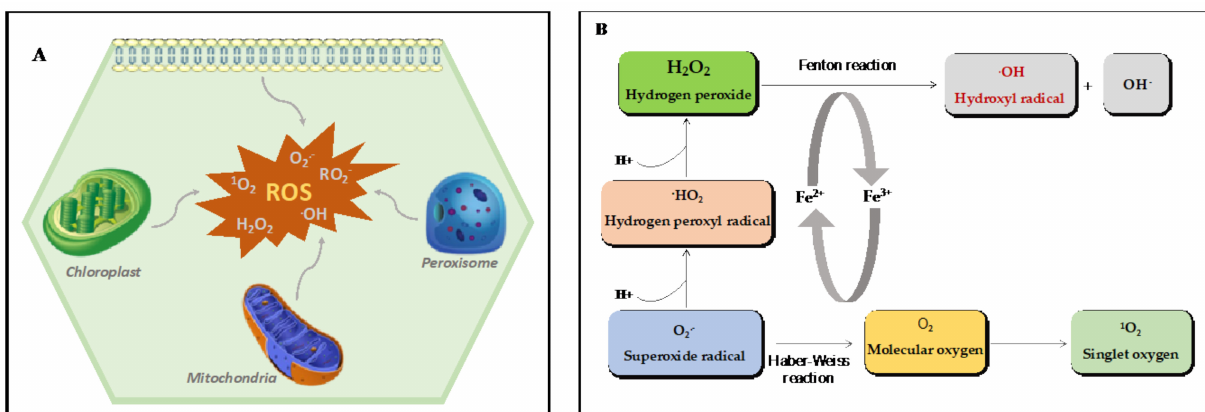
Figure 1. Environmental stress and ROS production in plants. ( A ) ROS are produced in the chloroplasts, mitochondria, peroxisomes, plasma membrane, cell walls, and apoplasts under normal growth conditions. However, environmental stresses exacerbate their production and may lead to oxidative stress. ( B ) The Fenton reaction and Haber–Weiss reaction. ROS are partially reduced or activated forms of molecular oxygen. About 1–5% of molecular oxygen consumed by plants leads to ROS generation. The different forms of ROS include superoxide radicals, singlet oxygen, hydrogen peroxide, perhydroxyl, and hydroxyl